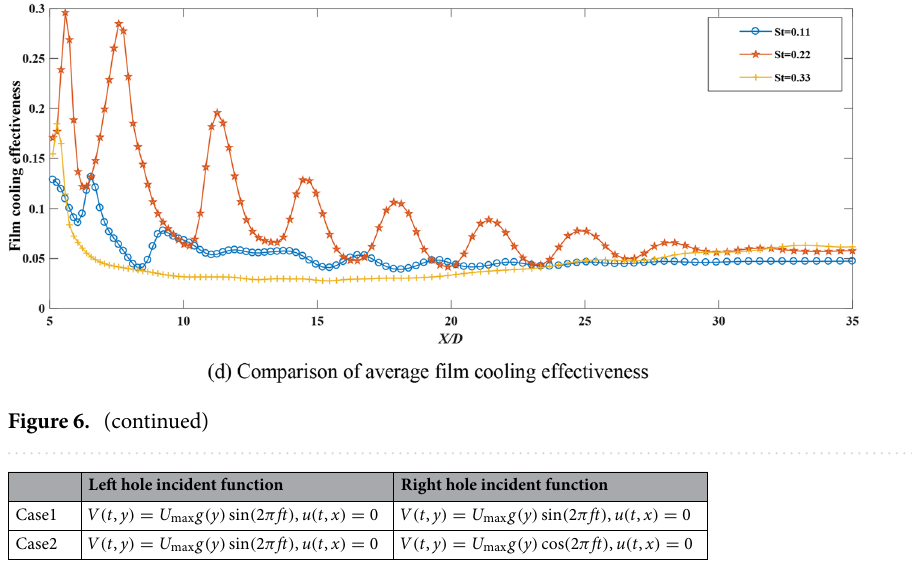
Table 1. The insertion function at two cases.